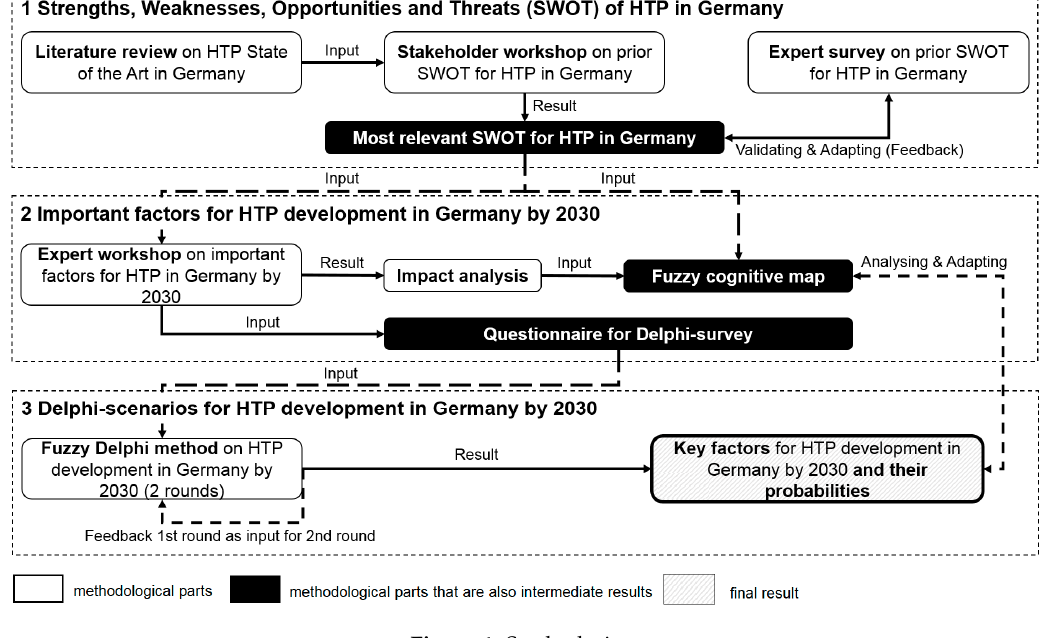
Figure 1. Study Figure 1. Study design.